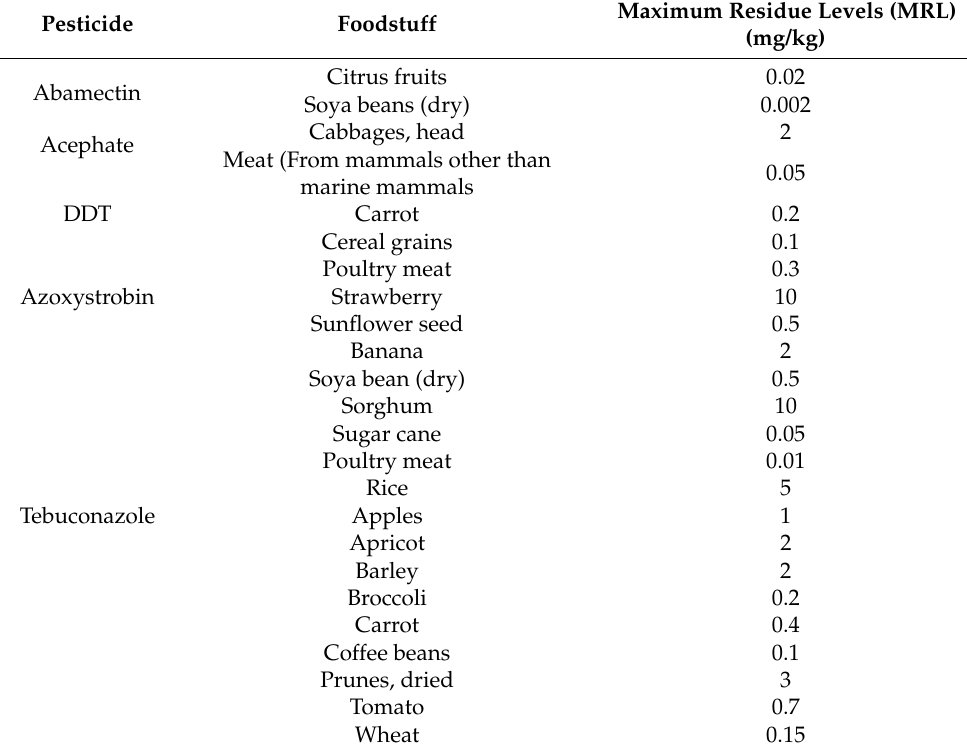
Table 3. Maximum levels for selected pesticides that may be present in foodstuffs as per the Codex Alimentarius International Food Standards